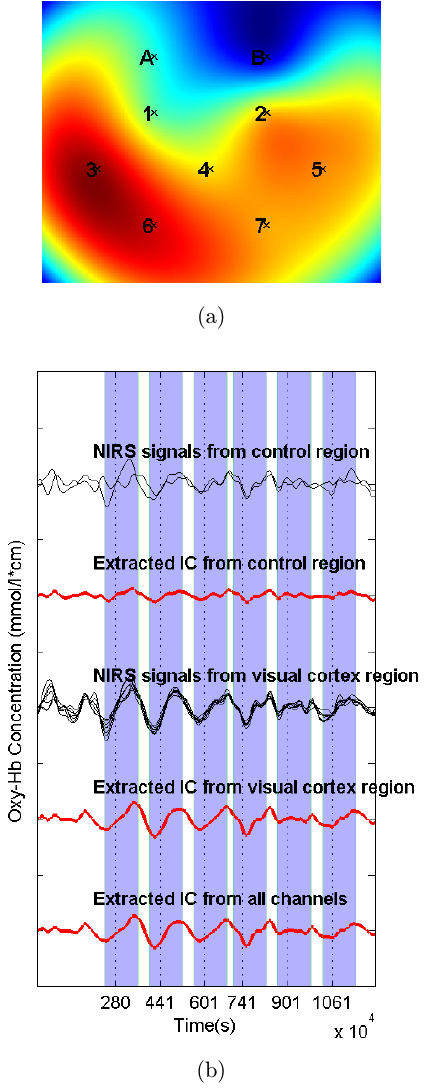
Fig. 6. Evoked Oxy-Hb responses with 10 Hz °ickering stimulus. (a) Spatial map of ICs extracted from all channels and (b) Extracted ICs and original signals of visual cortex region vs control region.